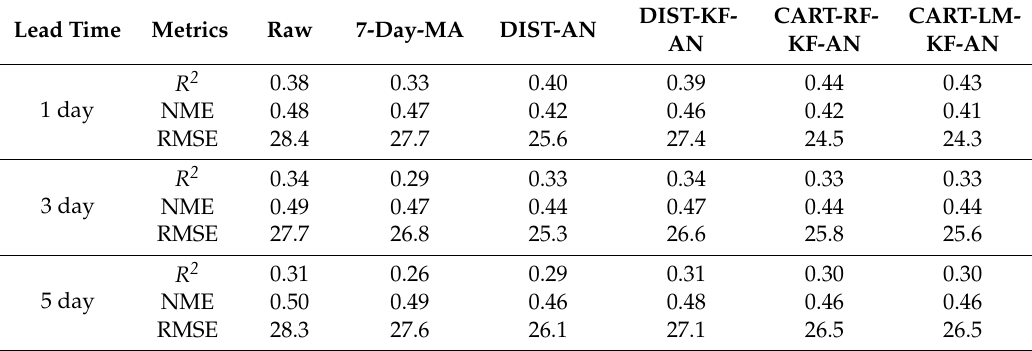
Figure 7. Percentage (%) of avg-monitors with increased R 2 values ( a ) and decreased NME ( b ) and RMSE values ( c ) by the five post-correction methods and for the 1, 3, and 5-day lead times by spatially interpolating the estimated biases. Table 3. Performance statistics for R 2 , NME, and RMSE (in ug/m 3 ) at locations without monitors after correction